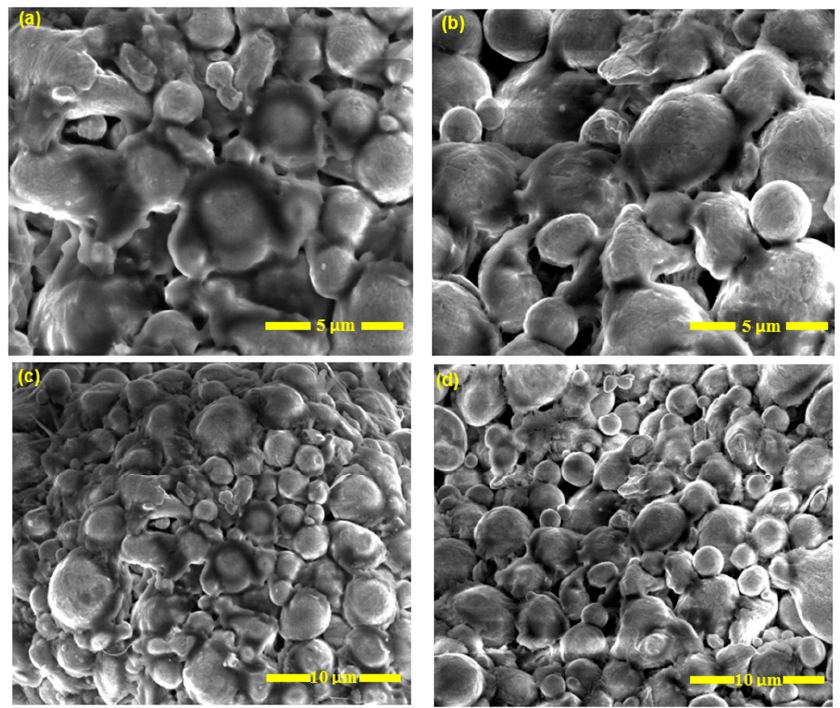
Figure 2. SEM image showing the ( a , c ) green part (before debinding/washing) and ( b , d ) solvent debound brown part (after debinding/washing).